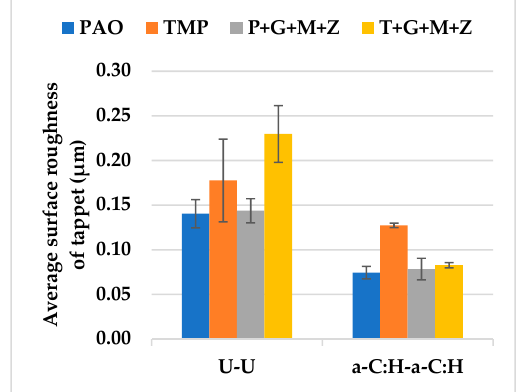
Figure 11. Average surface roughness of DLC-coated and uncoated tappets after cylinder head testing under various conditions in combination with uncoated and DLC-coated camlobes with TMP-based and PAO-based lubricants.